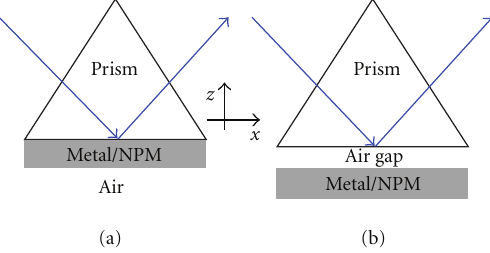
Figure 2: Kretschmann configuration (left), Otto configuration (right).